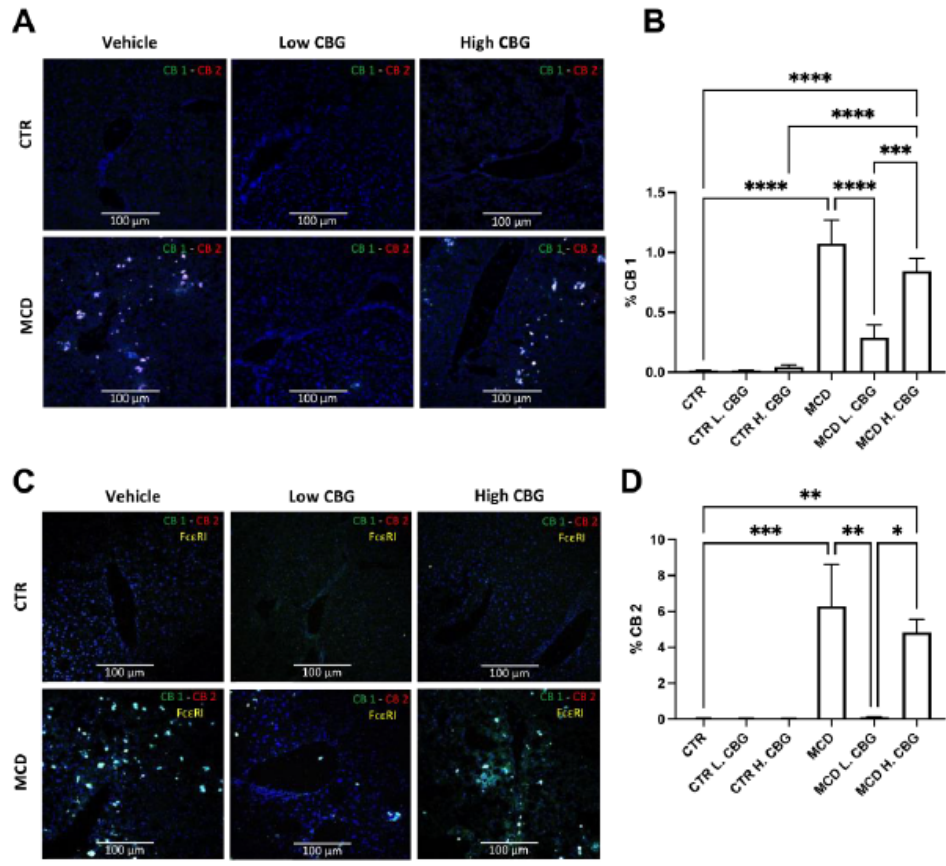
Figure 5. Evaluation of CB receptors with Fc ε R1 co-localization in liver frozen sections. Immunofluorescence staining of frozen liver sections for CB1 andCB2 ( A , 20 × ), illustrating CB1 in green and CB2 in red. Then, the expression of Fc ε RI was overlayed to assess co-localization ( C ). % CB1 ( B ) and CB2 ( D ) were quantifies using imageJ software. * p < 0.05, ** p < 0.01, *** p < 0.001, **** p < 0.0001.